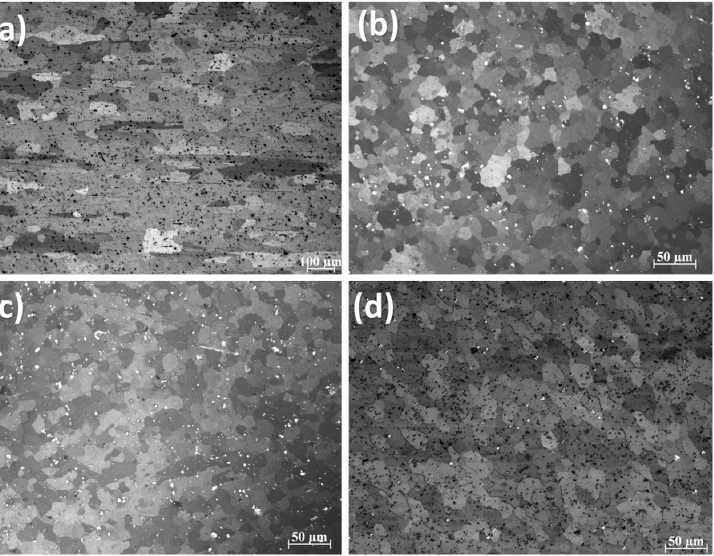
Figure 3. Optical microstructure images of the investigated composites: ( a ) AA7075 wrought alloy, ( b ) monocomposite AA7075/GNPs, ( c ) hybrid composite AA7075/GNP+BN, ( d ) hybrid composite AA7075/GNP+BN+VC.